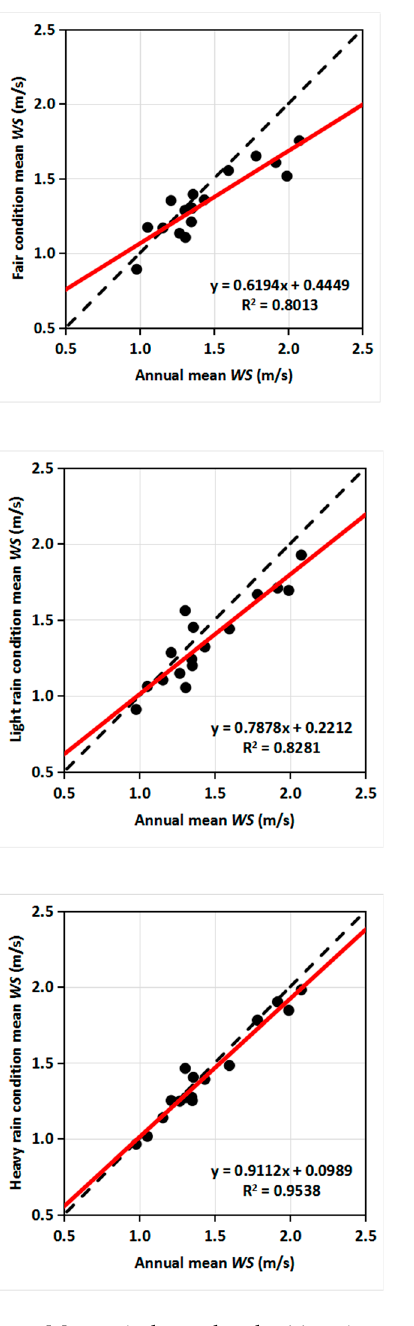
Figure 7. Mean wind speed at the 16 stations and local climate zone ventilation performance sequences under different precipitation conditions.